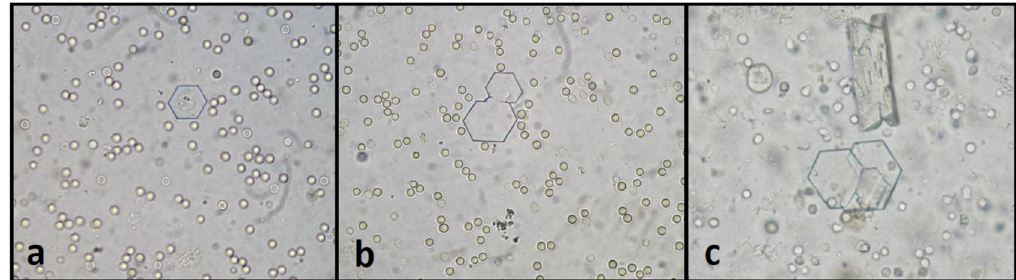
Figure 3. Canine cystine crystals as colorless hexagonal plates in unstained urine sediment (( a , b )–surrounded by erythro- cytes, ( c )–surrounded by leukocytes and struvite crystal).